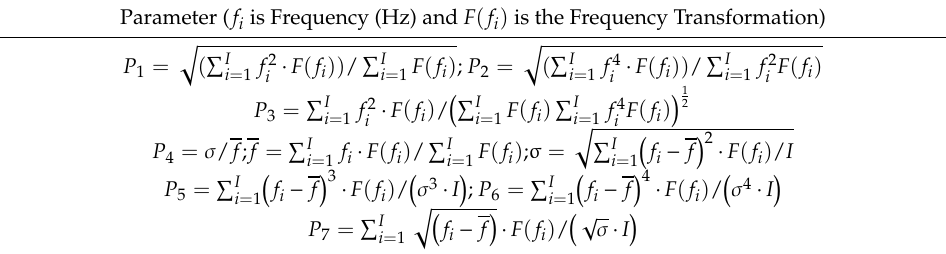
Table 8. Feature parameters in frequency